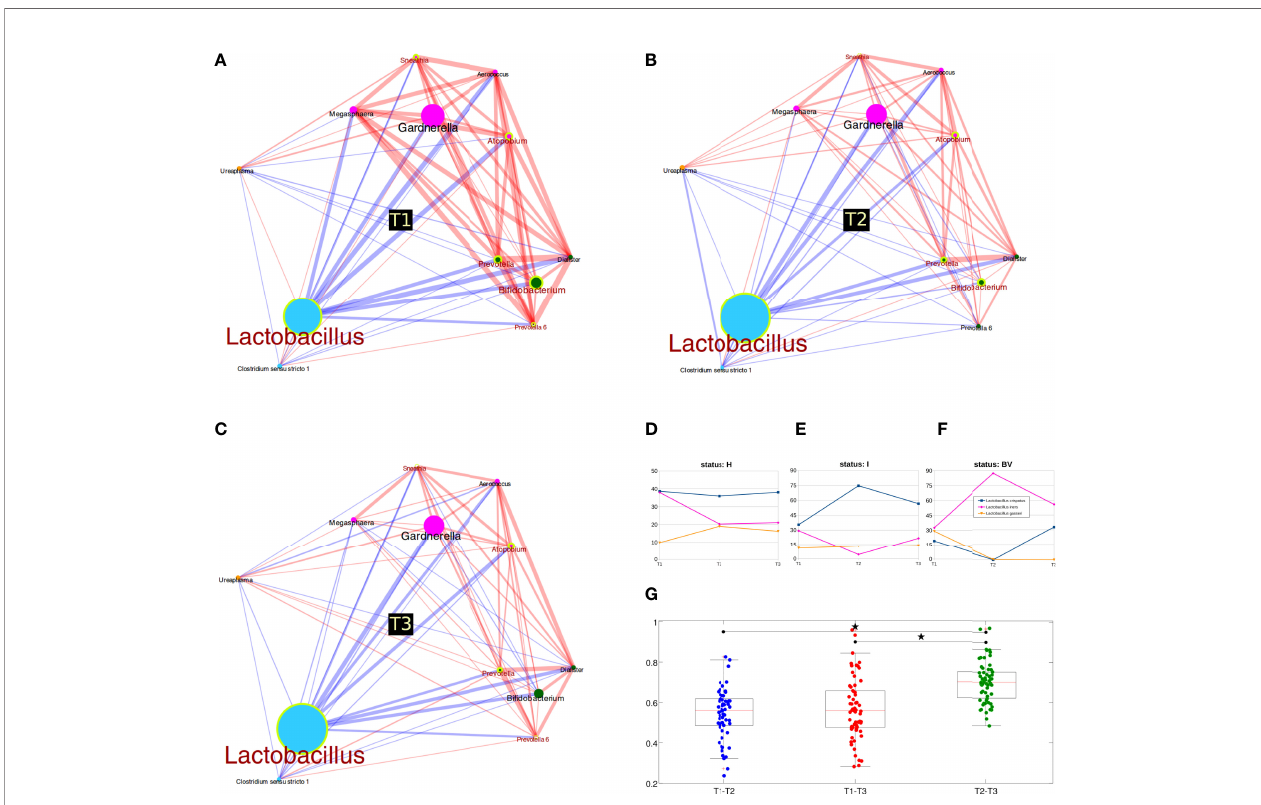
FIGURE 2 | Microbiota evolution during three trimesters of pregnancy. (A – C) Co-abundance networks of bacterial genera over time. Circle size is proportional to genus relative abundance for each time and colors are according to co-abundance groups (see also Suppl_Figure3_heatmap_CAGnetwork); edge size is proportional to the strength of correlation; red lines mean positive correlation, while blue lines indicate negative correlation. Genera resulting statistically different over time points are highlighted with a yellow circle and a red label; (D – F) Lactobacillus species abundance over time, strati fi ed for vaginal status. Only the three most abundant species are represented; (G) Boxplot of unweighted Unifrac distances between samples over time. Distances were calculated for each pair of samples belonging to the same women, sampled at T1, T2 or T3; stars above the plots represent statistical signi fi cance